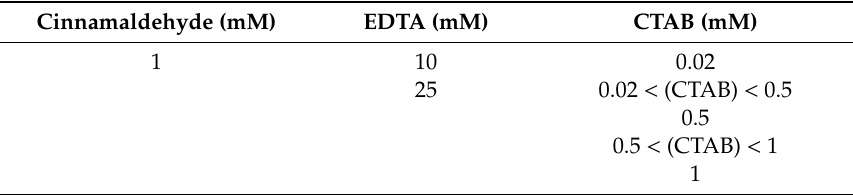
Table 1. Concentrations tested for cinnamaldehyde, EDTA, and CTAB in combination by using the suspension test against Escherichia coli NCTC 10418. EDTA: ethylenediaminetetraacetic acid and CTAB: cetyltrimethylammonium bromide.